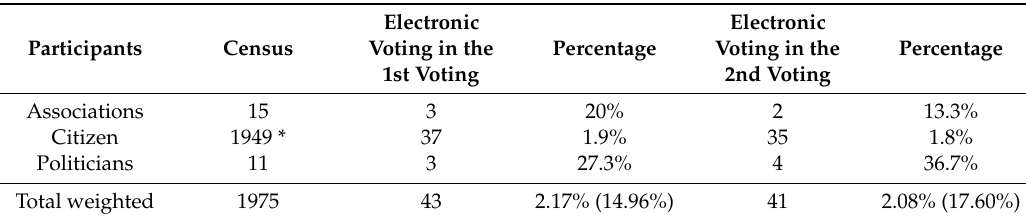
Table 3. The two rounds of voting.